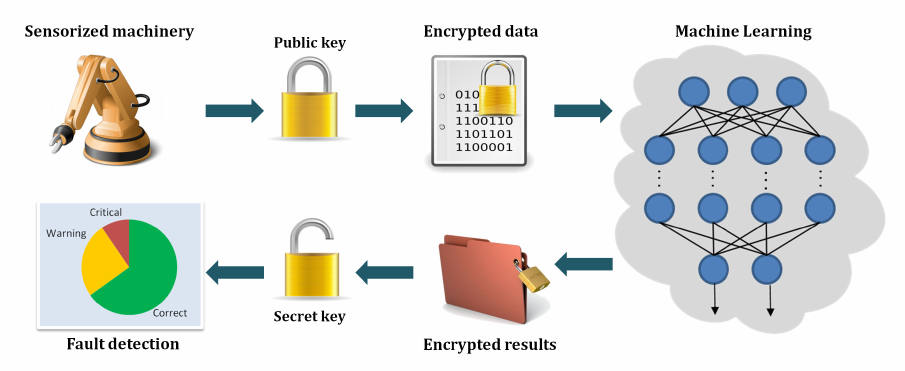
Figure 3. Machine learning over encrypted data for fault detection